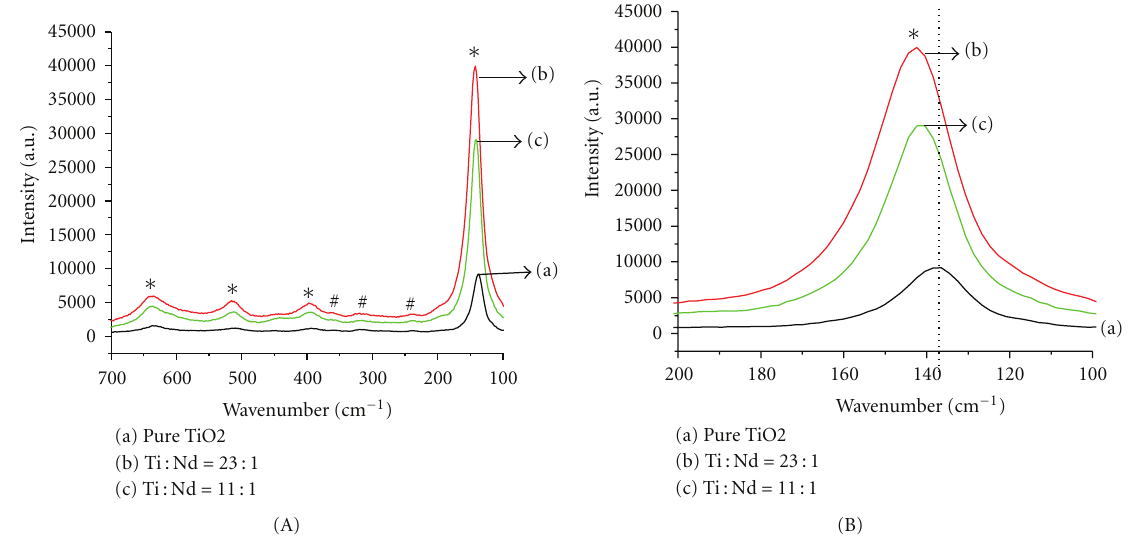
Figure 2: (A) Raman spectra of pure TiO 2 (a), Nd-doped TiO 2 with Ti: Nd = 23:1 (b), and Nd-doped TiO 2 with Ti:Nd = 11:1 (c). (B) The enlarged peak at 144.86 cm − 1 .